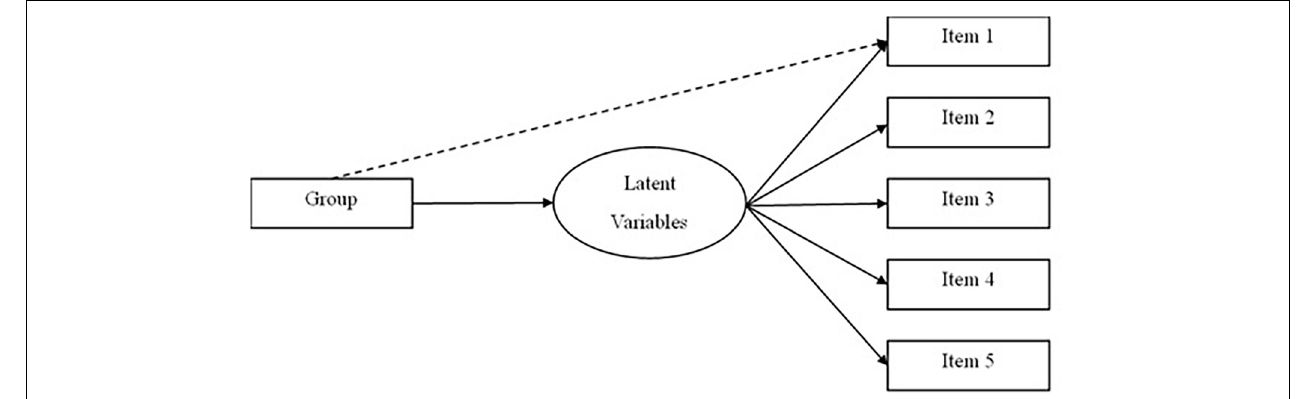
FIGURE 1 | Hypothetical multiple-indicator multiple-cause approach (MIMIC)